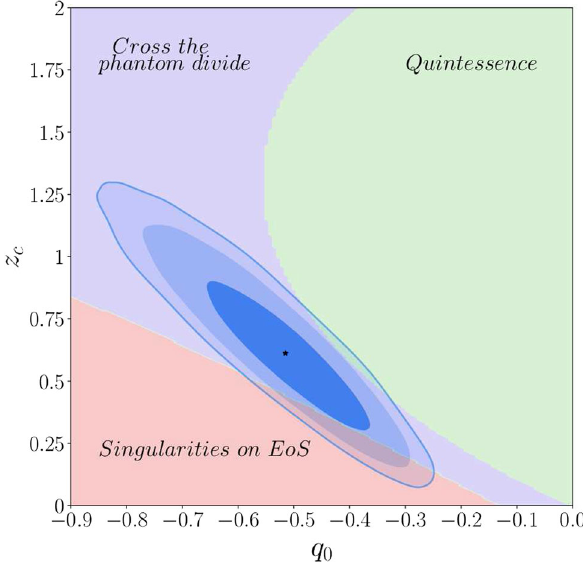
Fig. 6 Decision regions in the parameter space and the 68%, 95%, 99 . 7% confidence levels for the q 0 and z c parameters for the joint anal- ysisconstraints.TheclassificationoftheEoS(dependingonthegiven ω value) is represented in different regions: green for quintesence models; purple for quintom models; red for EoS with singular points. The black star represents the joint analysis (CC + Pantheon) mean values for z c and q